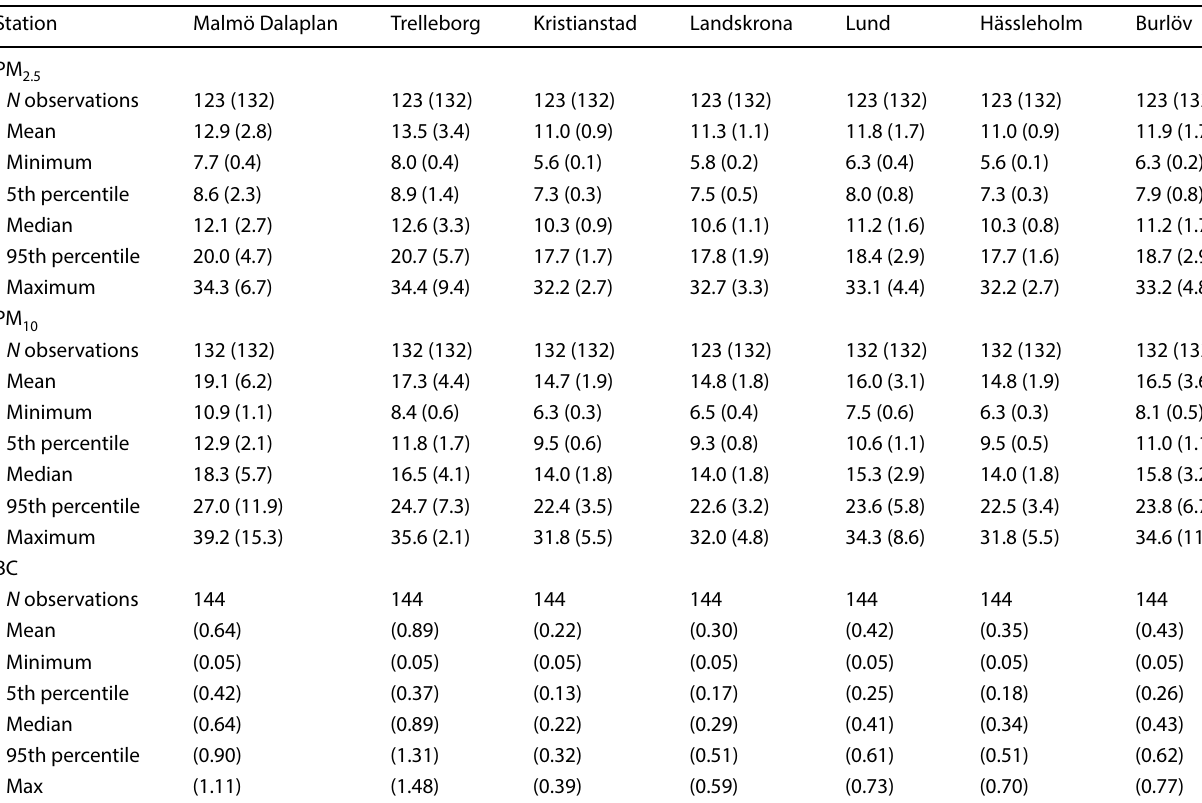
Table 1 Summary of modelled concentrations of particulate matter (PM) and black carbon (BC) in monthly averages in µg/m 3 over the study period, total levels with included background and levels without background in brackets